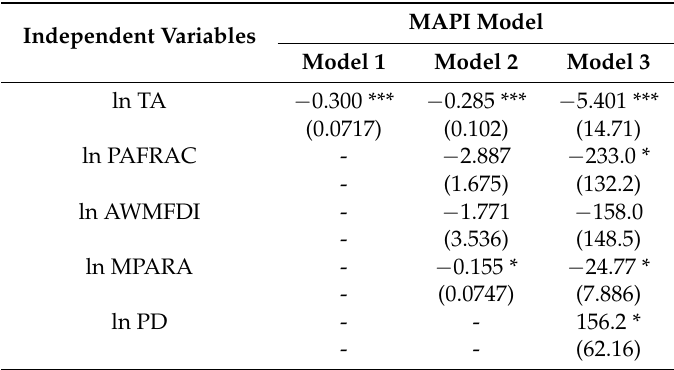
Table 7. Estimation results for MAPI